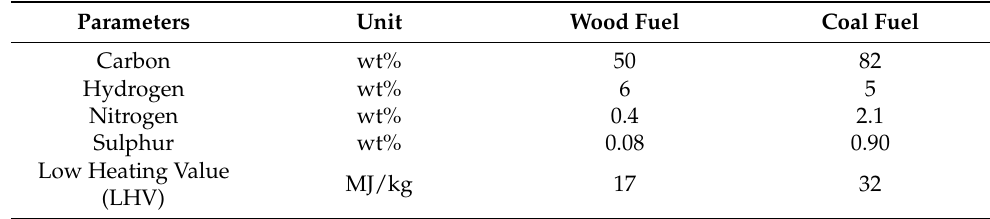
Table 3. Fuel properties and composition based on ultimate analysis on dry weight basis [59–62]. Parameters Unit Wood Fuel Carbon